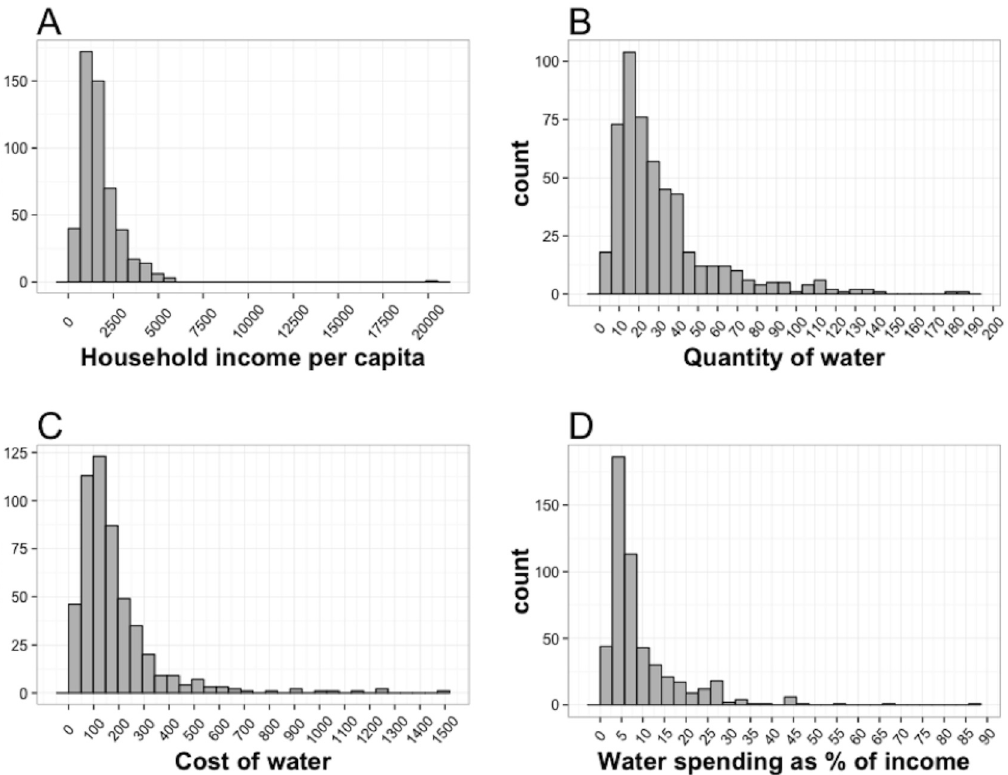
Fig 3. The distribution of water-related indicators in Kaula Bandar. (A) Household income per capita in the last month in Indian rupees (Gini coefficient = 0.31); (B) quantity of water consumed in liters per capita per day (Gini coefficient = 0.42); (C) price of water in Indian rupees per 1,000 liters of water (Gini coefficient = 0.41); and (D) water spending as a percentage of household income in the last month (Gini coefficient =